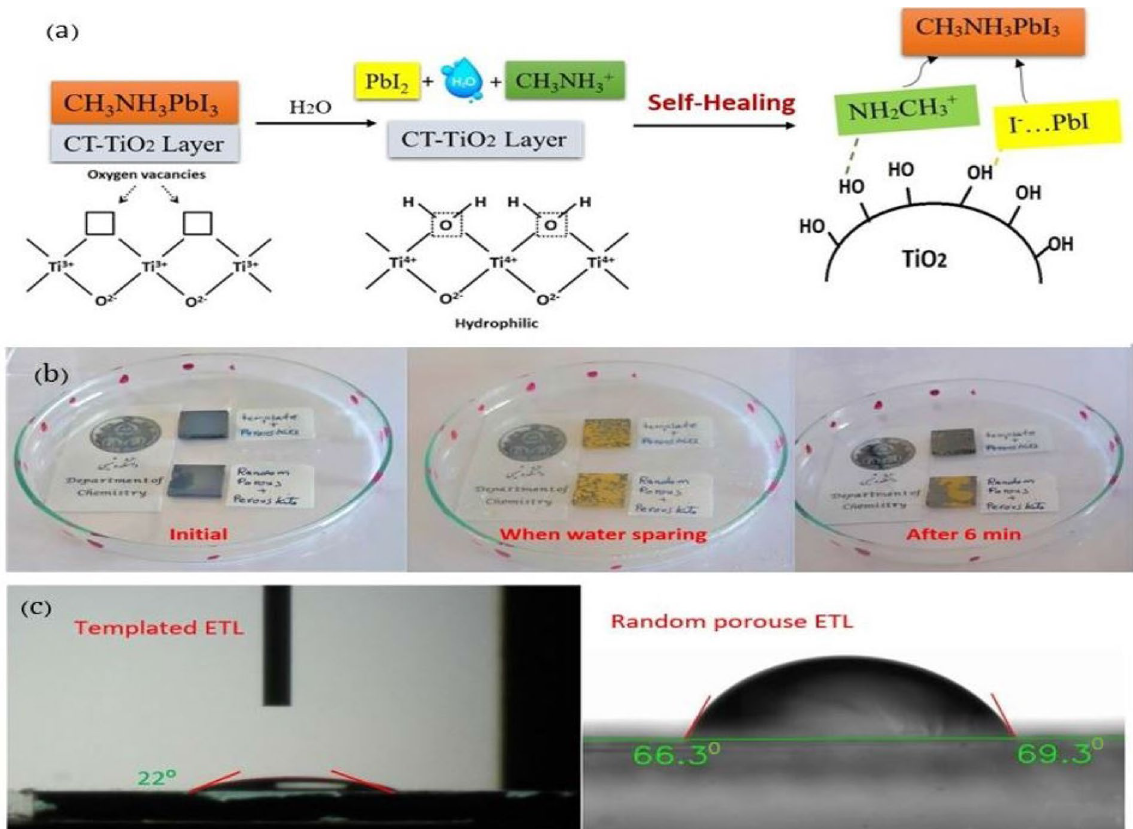
Figure 7. ( a ) Schematic representation of the mechanism for the self-healing perovskite on surface templated TiO 2 . ( b ) Images of perovskite films in healing test in the beginning, upon water-spraying, and after 6 min (movies and other images are in the supporting information), and ( c ) contact angle images of water on the templated structure (22°) and random porous (67°) TiO 2